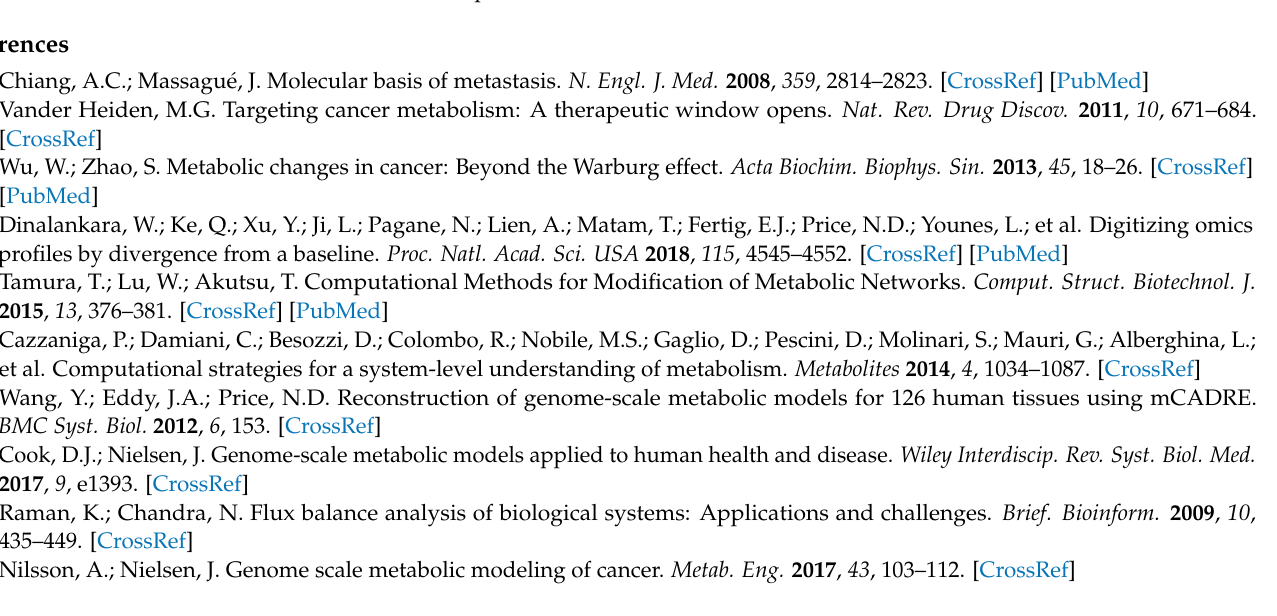
Supplementary Figure S4: PCA of normalized TPM values for metabolic genes. Supplementary file 1: Results of cluster-based analysis. Supplementary file 2: Drug sensitivity results for 1156 samples. Supplementary file 3: Methylation information and correlation analysis for genes identified from in silico knockout